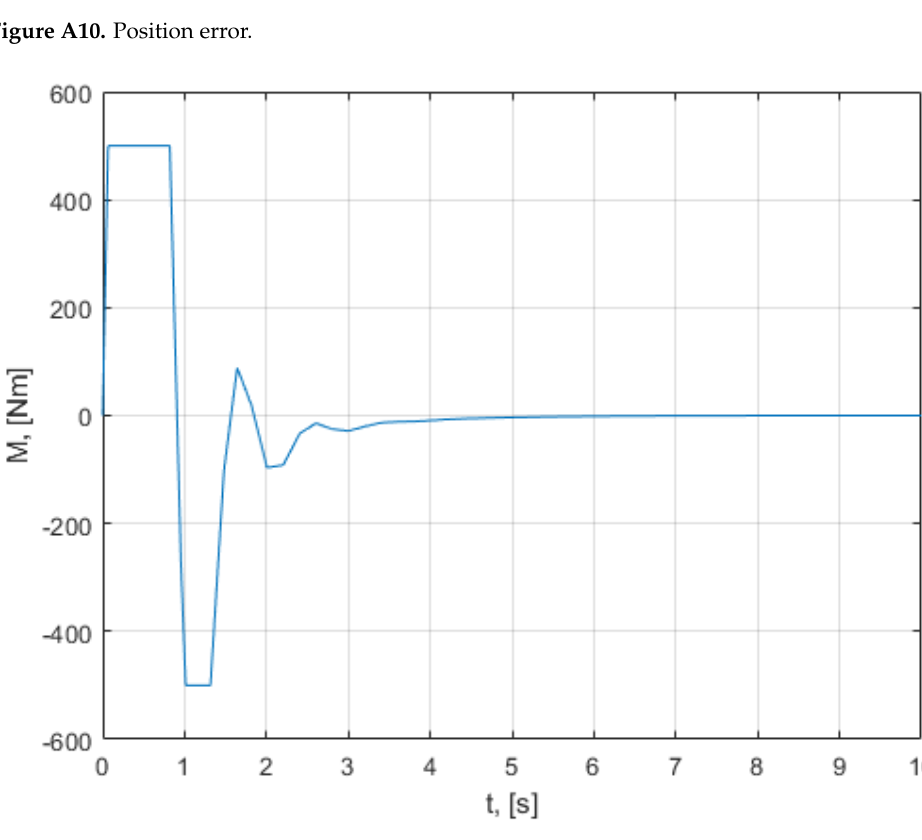
Figure A11. Torque. Figure A11.